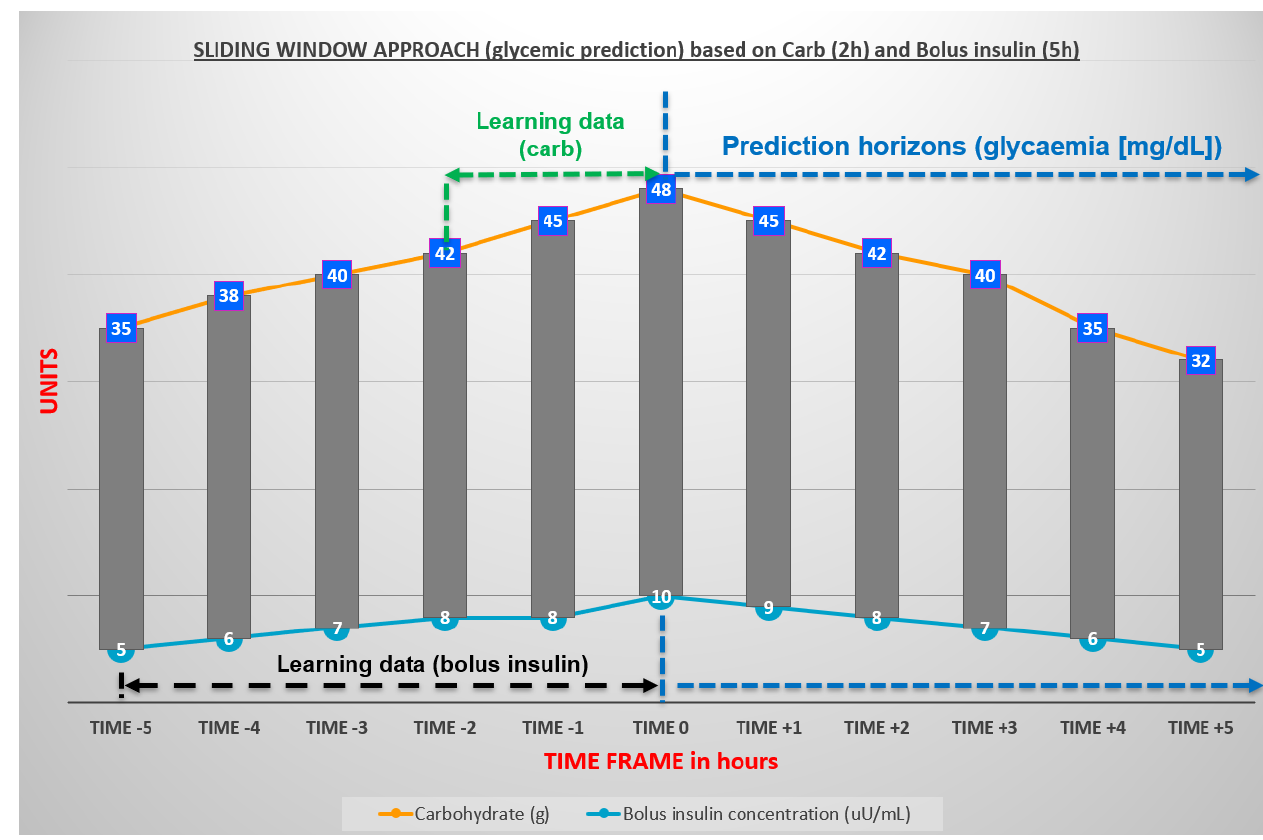
Figure 5. Sliding window approach for time series: carbohydrates and insulin.